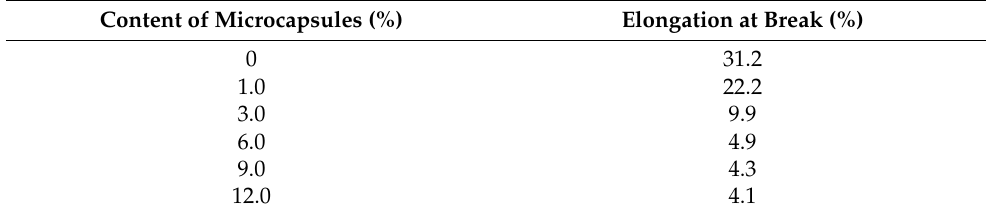
Table 15. Elongation at the break of the paint films.